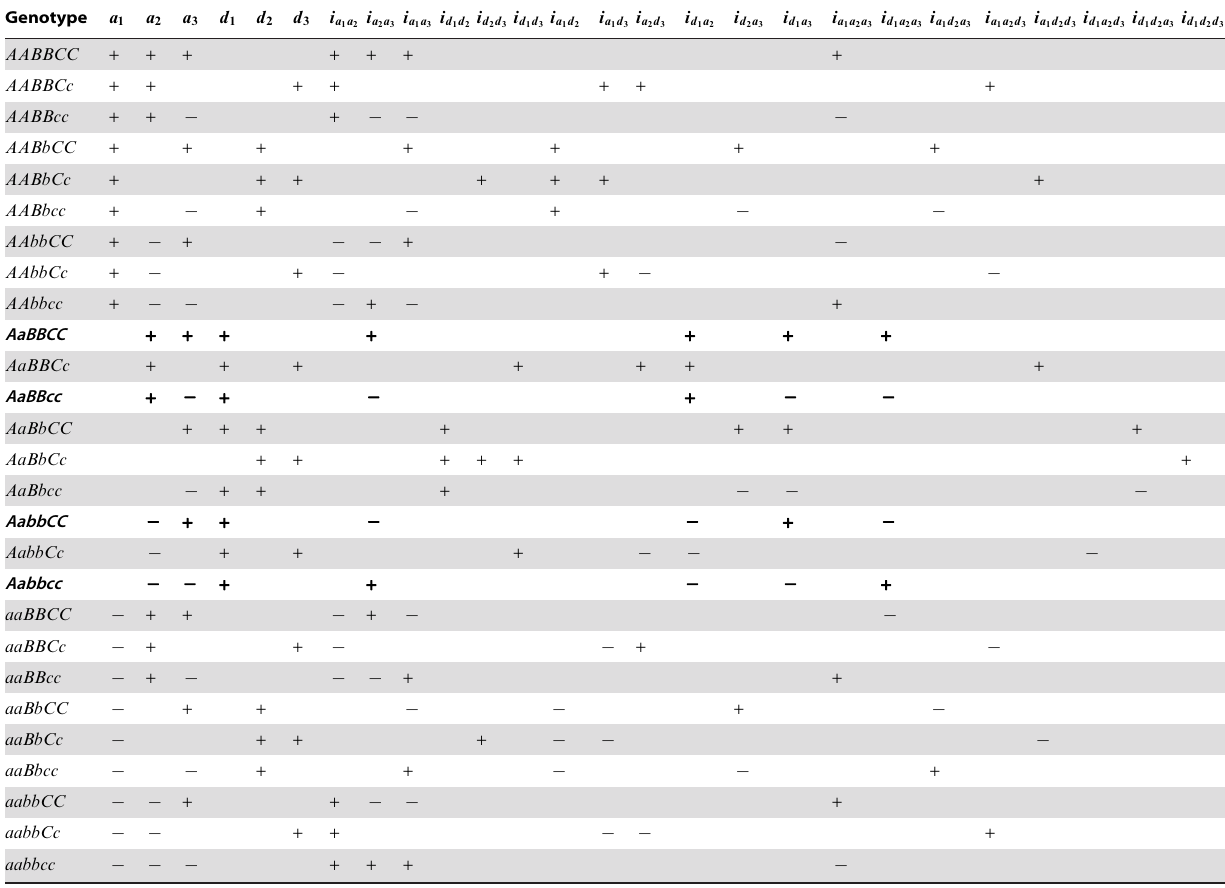
The p -values for those significant effects (in boldface) are given in parentheses. doi:10.1371/journal.pone.0011384.t008 Table 9. Genetic effect components of different three-locus genotypic